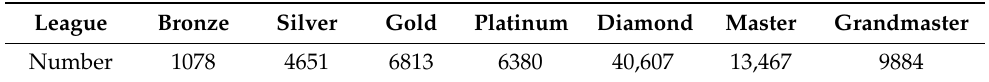
Table 1. Replay distribution by